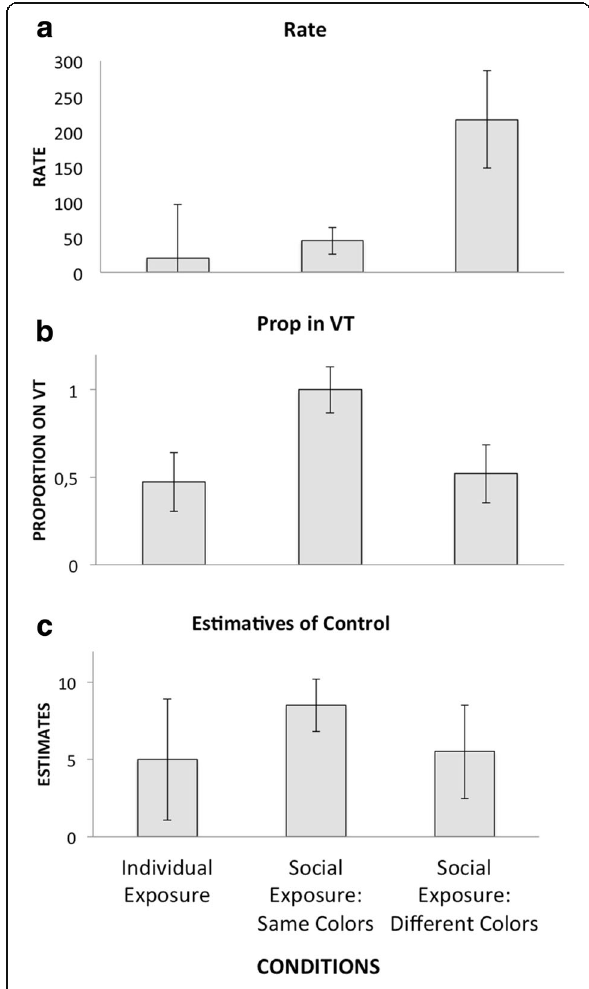
Fig. 4 Medians and standard deviations for response rate, proportion of responses in the VT component, and estimates of control in each of the experimental conditions. a Rate. b Prop in VT. c Estimatives of